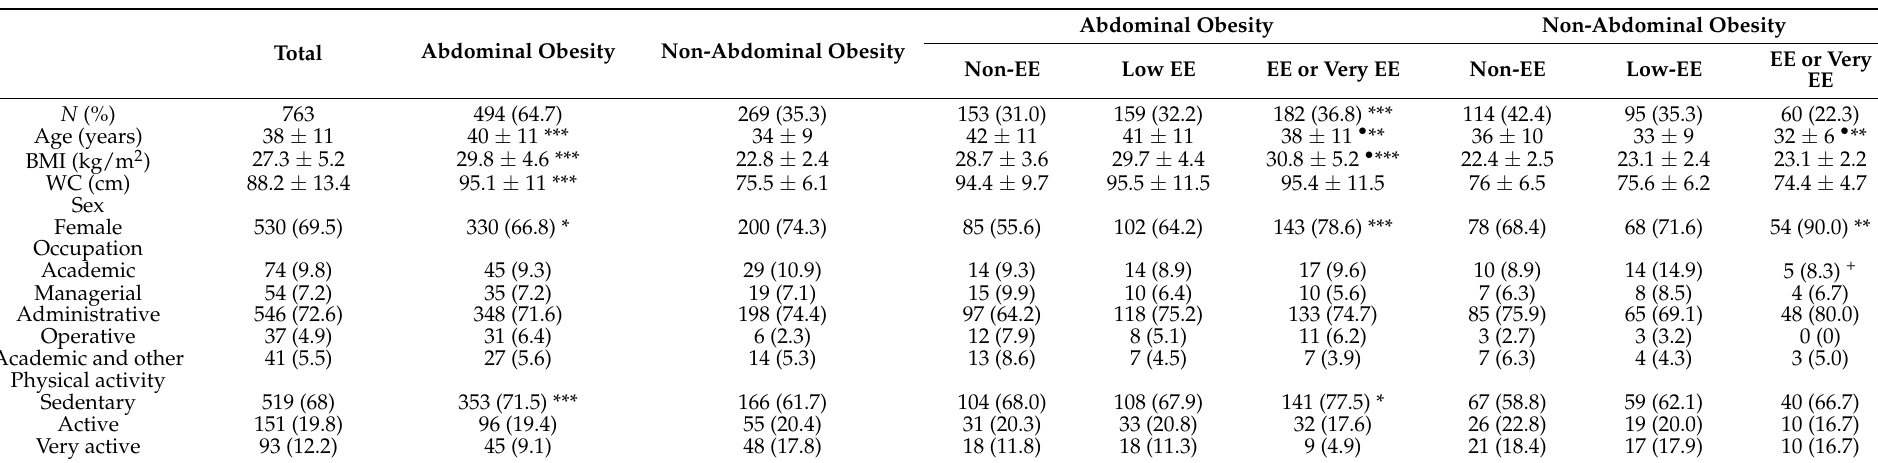
Table 2. Characteristics of the participants with and without abdominal obesity and according to the emotional eating classification. Abdominal Obesity Non-Abdominal Abdominal Obesity Non-Abdominal Obesity